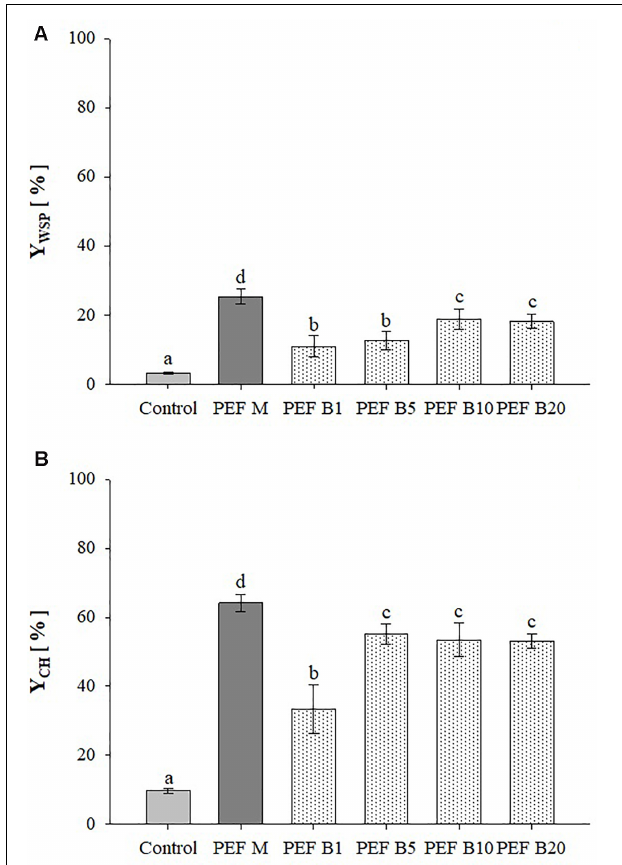
FIGURE 3 | Extraction yield of water-soluble proteins (A) and carbohydrates (B) in the supernatant of untreated (Control) and PEF-treated ( E = 20 kV/cm; W T = 100 kJ/kg susp ; T IN = 25 ◦ C) A. platensis suspensions with either monopolar (M) or bipolar (B) pulses at variable delay time (1, 5, 10, and 20 µ s). The yields were calculated considering 100% extraction yield upon the HPH treatment ( P = 150 MPa, n P = 3). Different letters above the bars indicate significant differences among the mean values ( p ≤